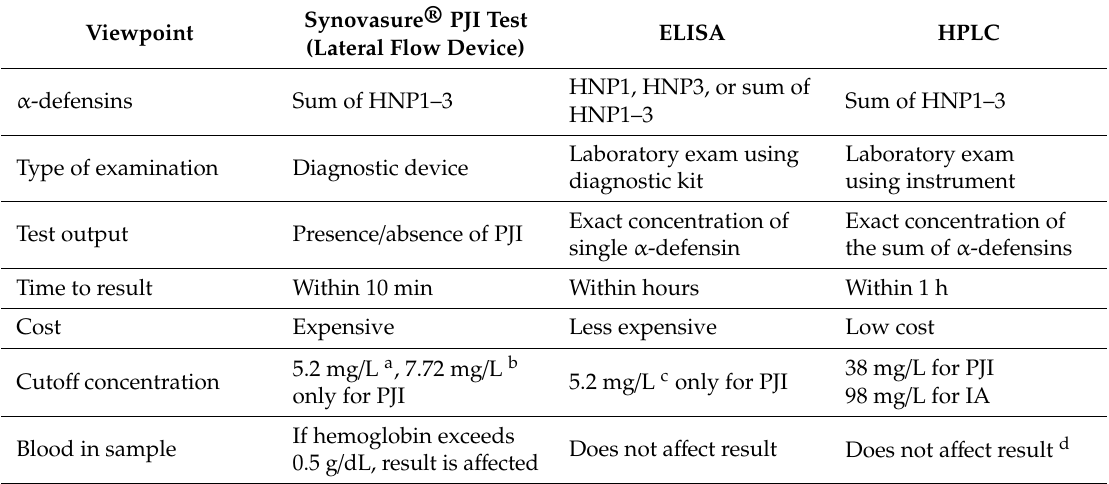
Table 2. Comparison from various viewpoints of methods available for detecting α -defensins